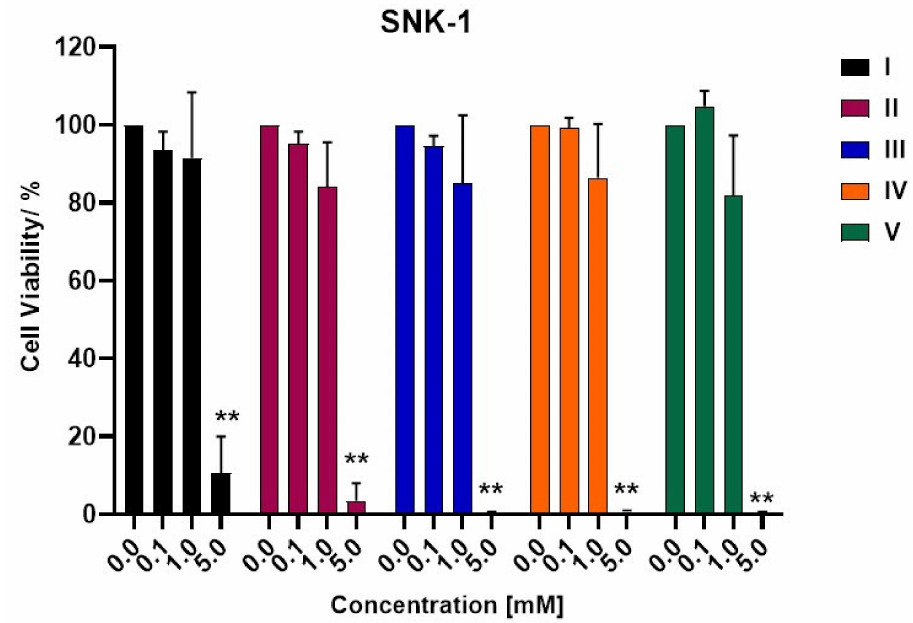
Figure 8. Compounds I – V demonstrates cytotoxicity starting from 5 mM in Natural Killer T-cell lymphoma cell line SNK1. Cells were treated with 0, 0.1, 1.0 and 5.0 mM of indicated drugs for 48 h. Cell survival was determined using the CellTiter-Glo ® Luminescent Cell Viability Assay (Promega). One-way ANOVA followed by Bonferroni post hoc test were used to assess significant differences between the treatment groups and the vehicle control. ** p <